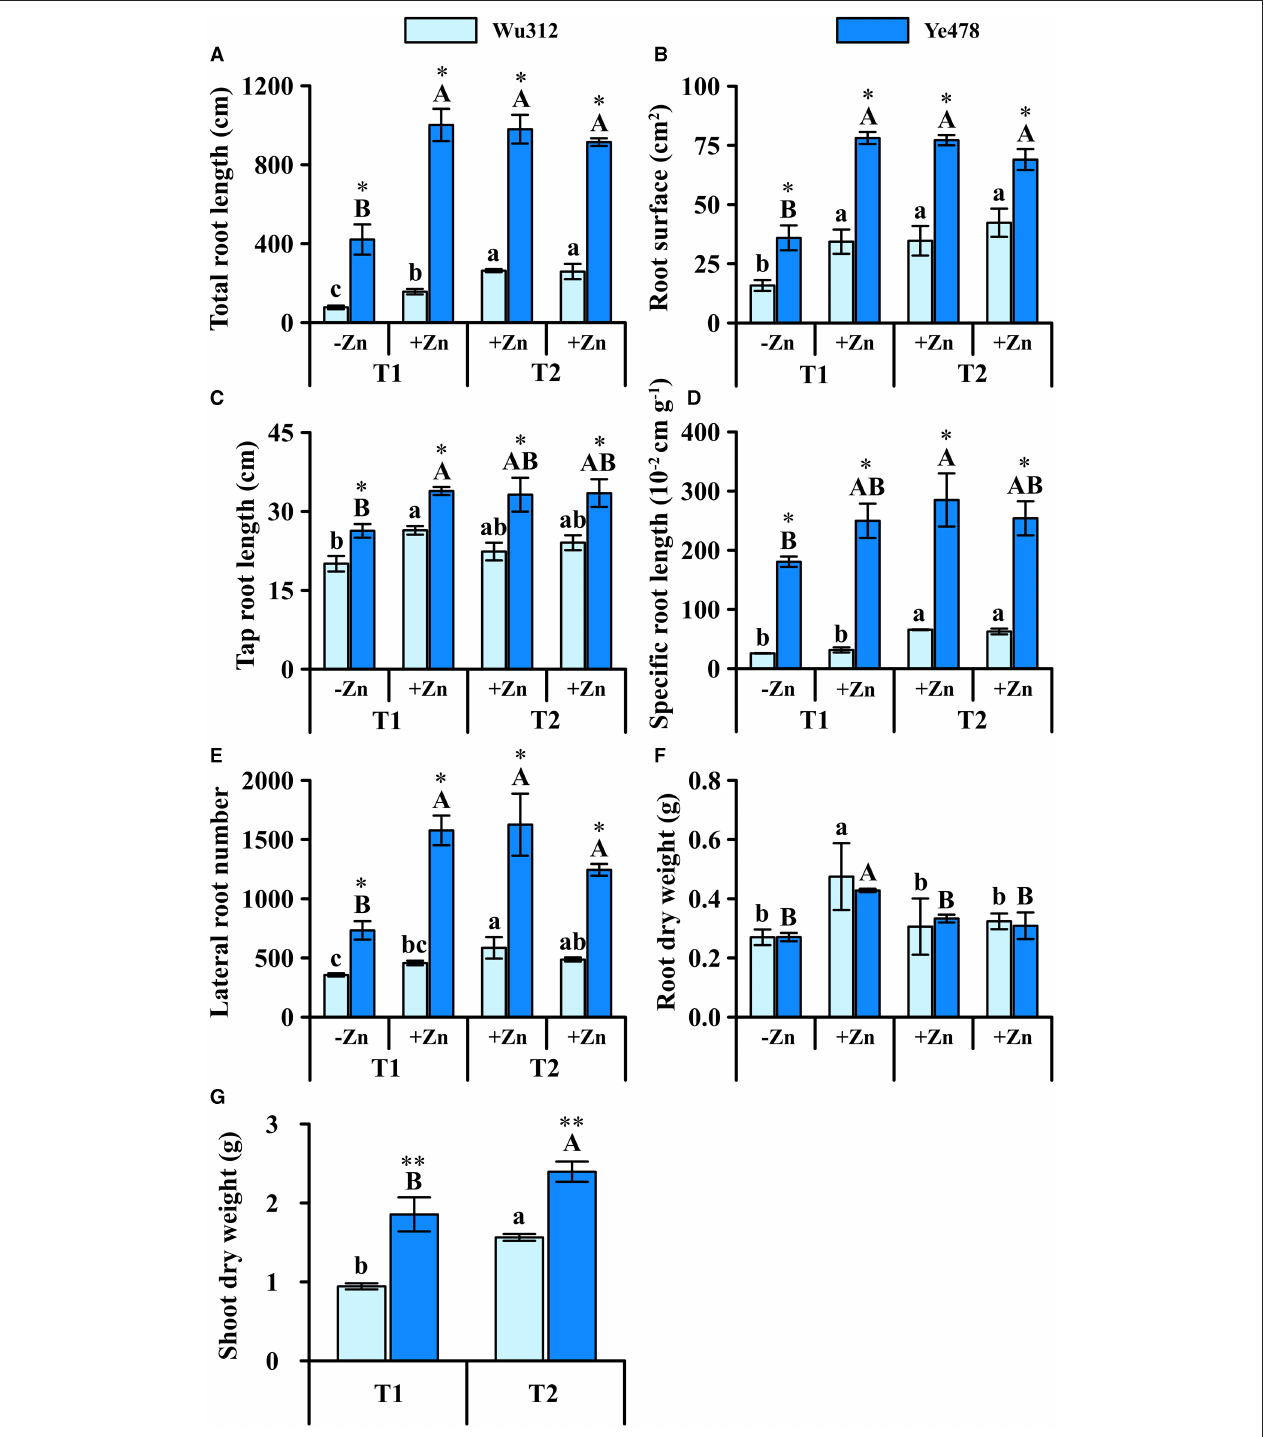
FIGURE 6 | Total root length (A) , root surface (B) , tap root length (C) , specific root length (D) , lateral root number (E) , root (F) , and shoot (G) dry weight of Zn-sensitive inbred line Wu312 and Zn-tolerant inbred line Ye478 under split-supply with –Zn (0.5 µ M) and + Zn (8 µ M) (T1) and with + Zn (8 µ M) and + Zn (8 µ M) (T2) in Experiment 3. Different lowercase and upper letters indicate significant difference ( p < 0.05) of Wu312 and Ye478 among treatments, respectively. * and ** indicate significant difference between Wu312 and Ye478 at p < 0.05 and p < 0.01, respectively.